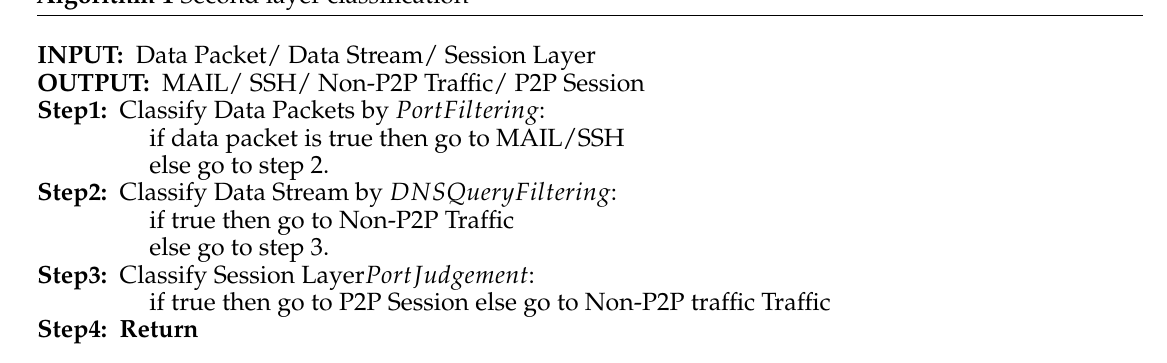
Algorithm 1 Second layer classification